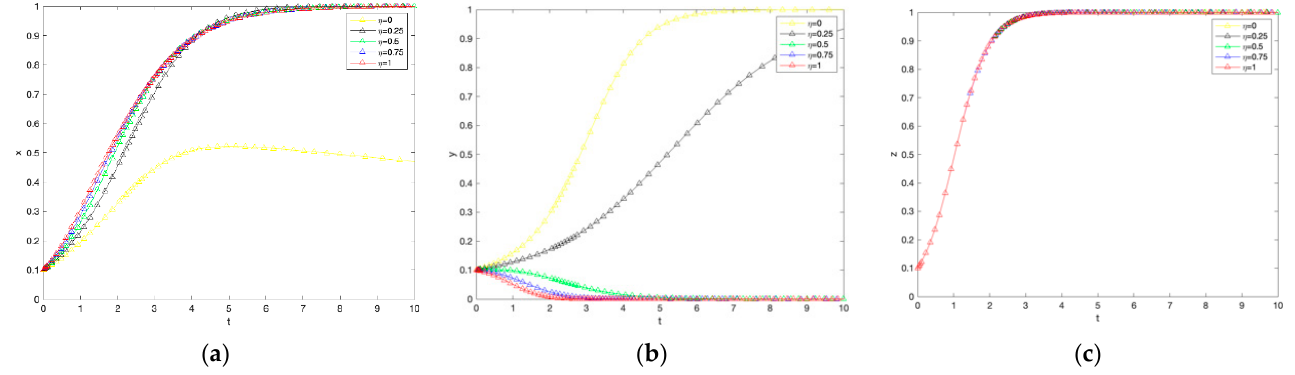
Figure 3. The impact of changes in the penalty coefficient on government subsidies, farmer adoption, and consumer purchases. ( a ) Government response. ( b ) Farmers’ response. ( c ) Consumer reaction.